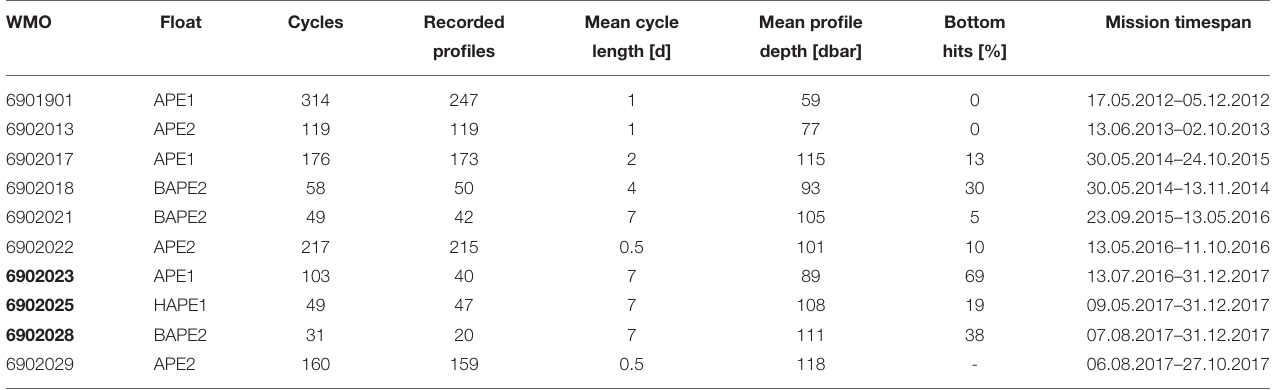
TABLE 2 | Argo float deployments in the Bothnian Sea in 2012–2017. Cycles Recorded Mean cycle Mean profile Bottom Mission timespan profiles